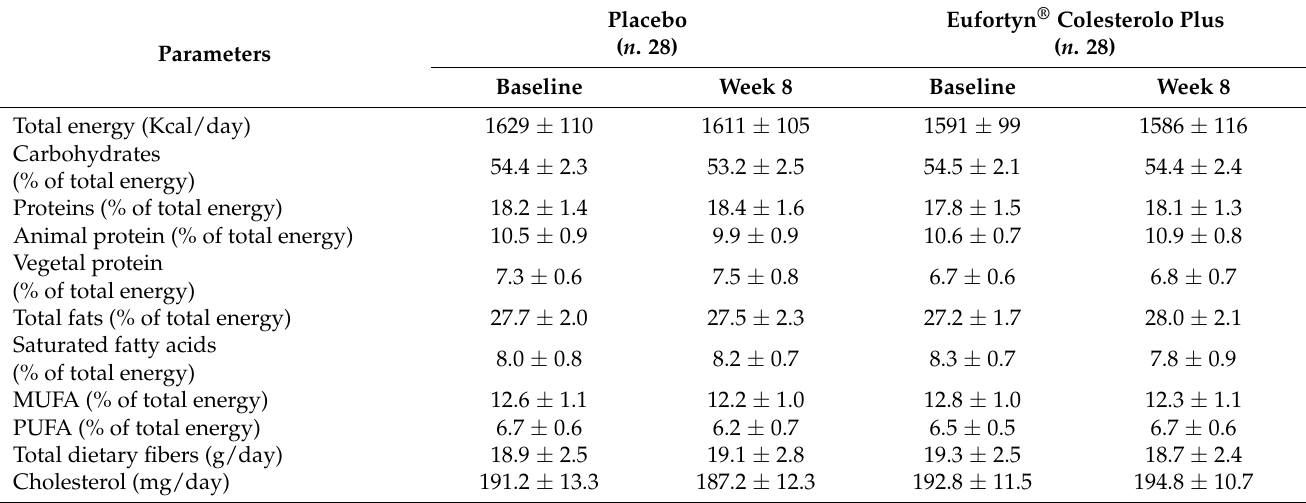
Table 2. Diet composition (g/day) at enrollment and at the end of the clinical trial. Values are reported as mean ±